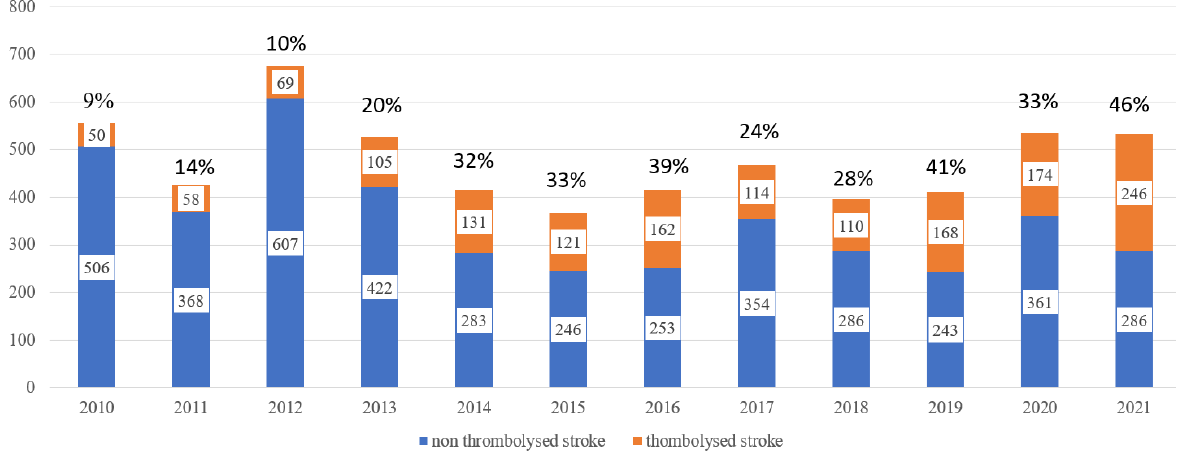
Figure 3. All stroke and thrombolysed stroke patients and percent of thrombolysed patients since 2010. Thrombolysed stroke mimics since 2018 are excluded.